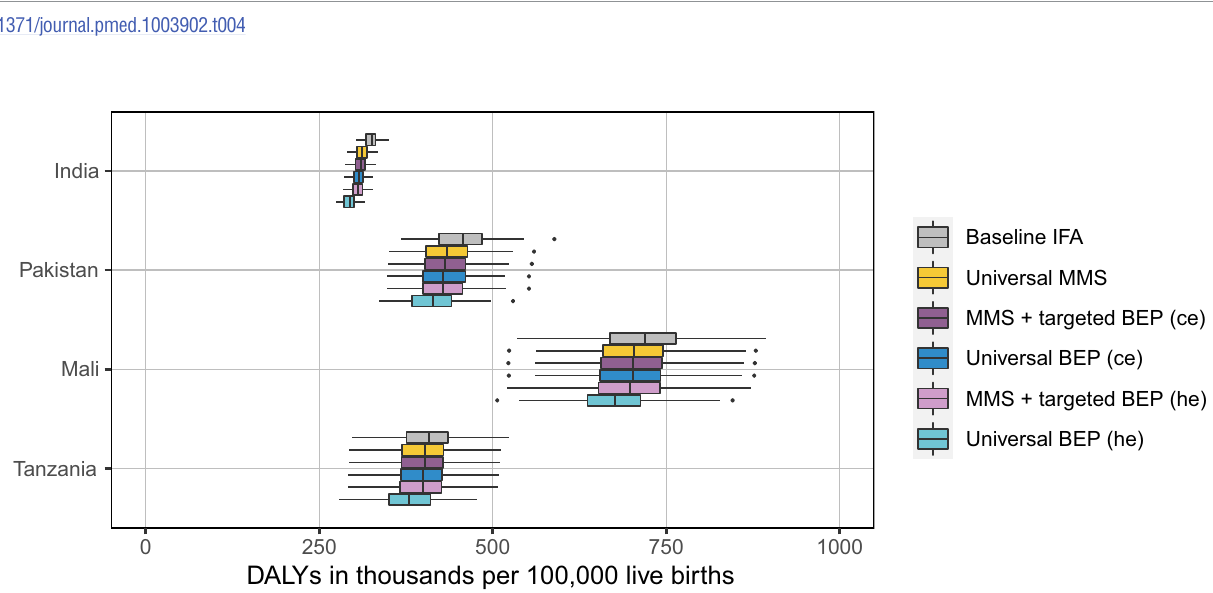
� Causes of morbidity and mortality affected by LBW according to the 2017 GBD study criteria for causality include neonatal preterm birth, neonatal encephalopathy, lower respiratory tract infection, other neonatal disorders, neonatal sepsis, hemolytic disease and jaundice, upper respiratory tract infections, otis media, diarrhea, meningitis, and encephalitis.